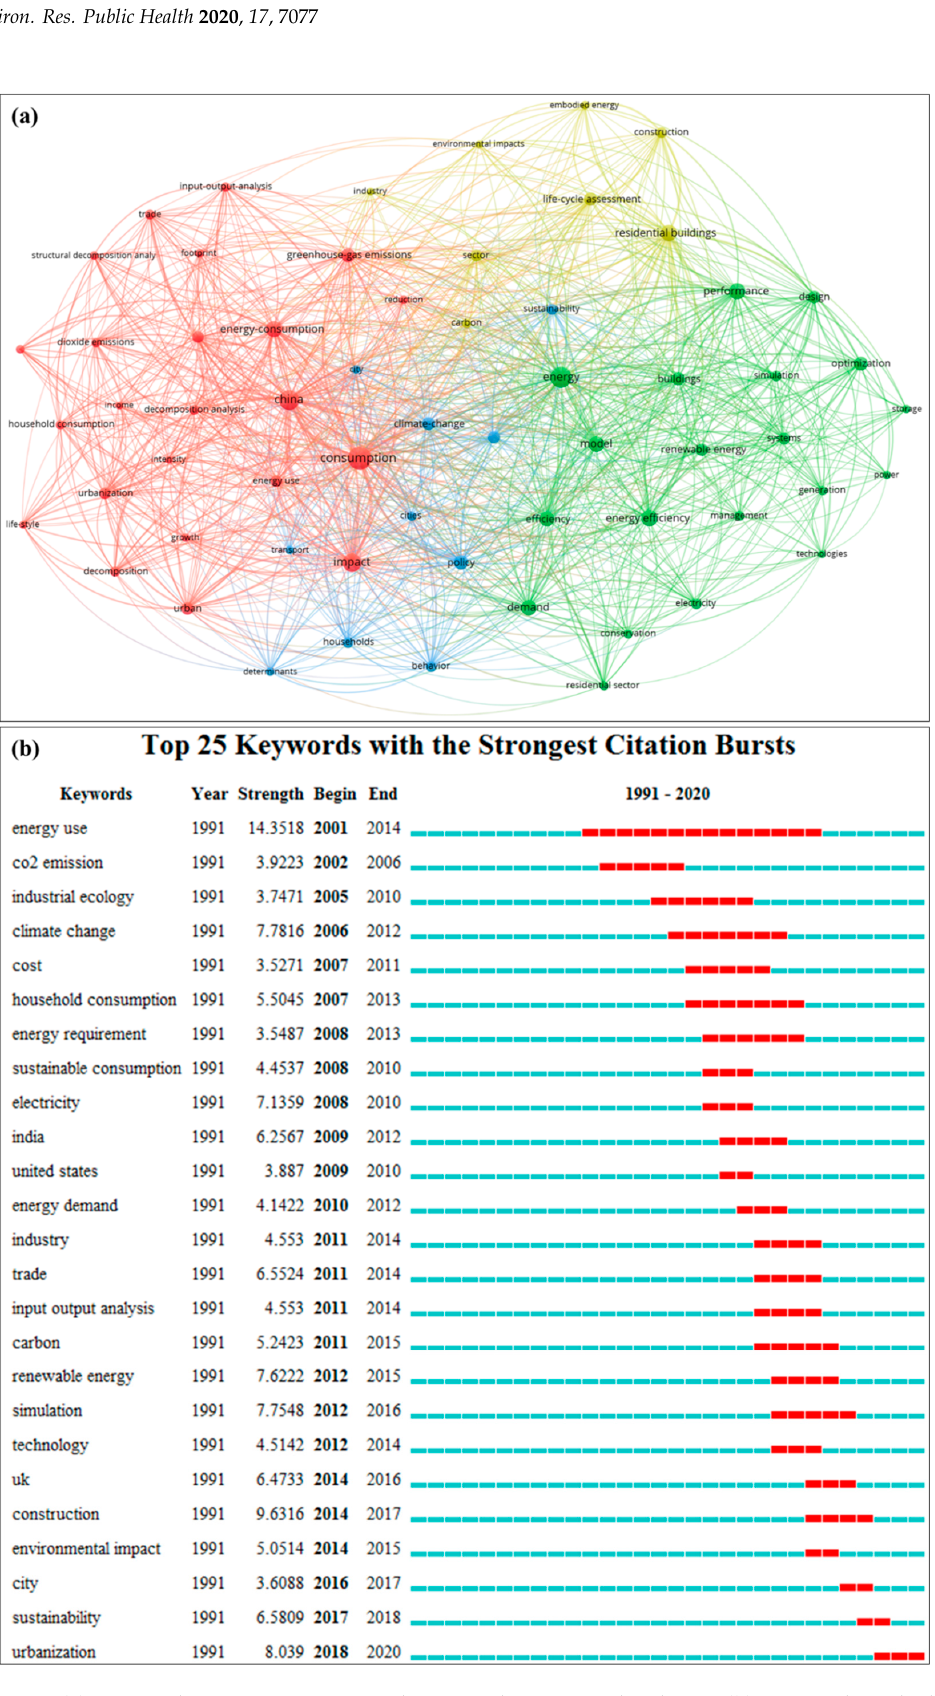
Figure 5. ( a ) Keyword co-occurrence network map without research subjects; ( b ) Keywords ranked by burst detection.